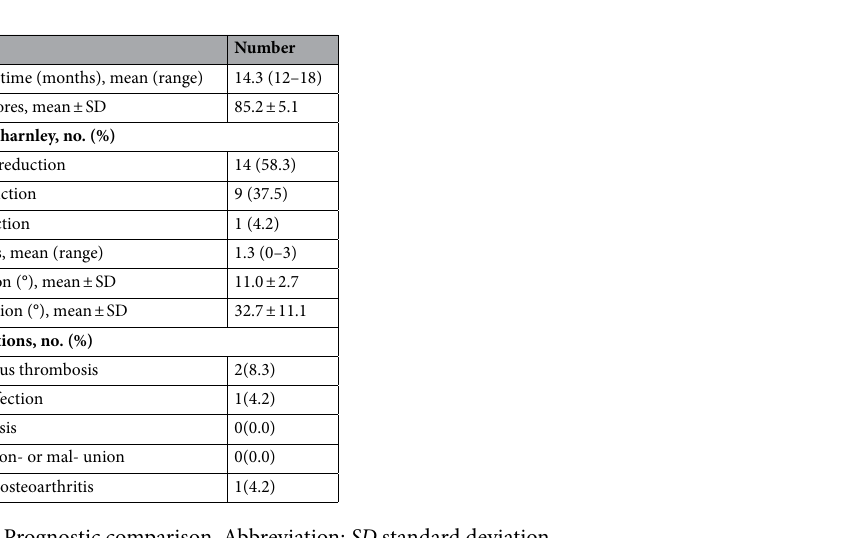
Table 3. Prognostic comparison. Abbreviation: SD standard